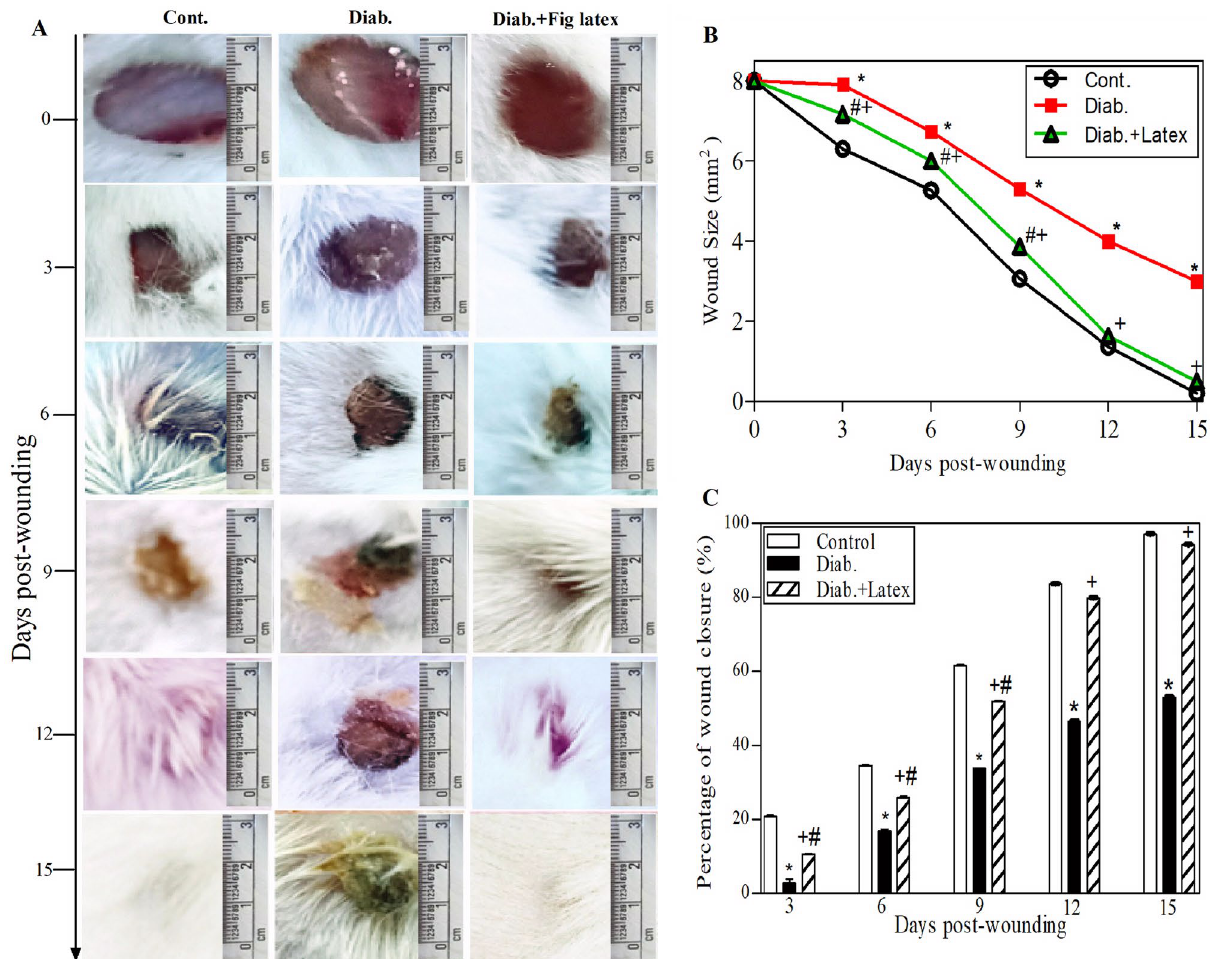
Figure 6. Effect of fig latex on wound healing and wound closure in diabetic mice. ( A ) Photographs showing the effect of fig latex on accelerating the healing process in diabetic wounds at each time point from Day 0 (the day of wound creation) until Day 15 (final point). ( B ) The accumulated data from three individual mice in each group at each time point post-wounding represent the change in diameter (mm). ( C ) The accumulated results from three animals in each group for each time point post-wounding were calculated by the previously mentioned equation in the Methods section, and the results show the percentage of wound closure. The data are expressed as the mean ± SEM. * P < 0.05, Diab. versus cont., + P < 0.05, diabetic mice treated with Latex versus cont., # P < 0.05, diabetic treated with Latex versus diabetic